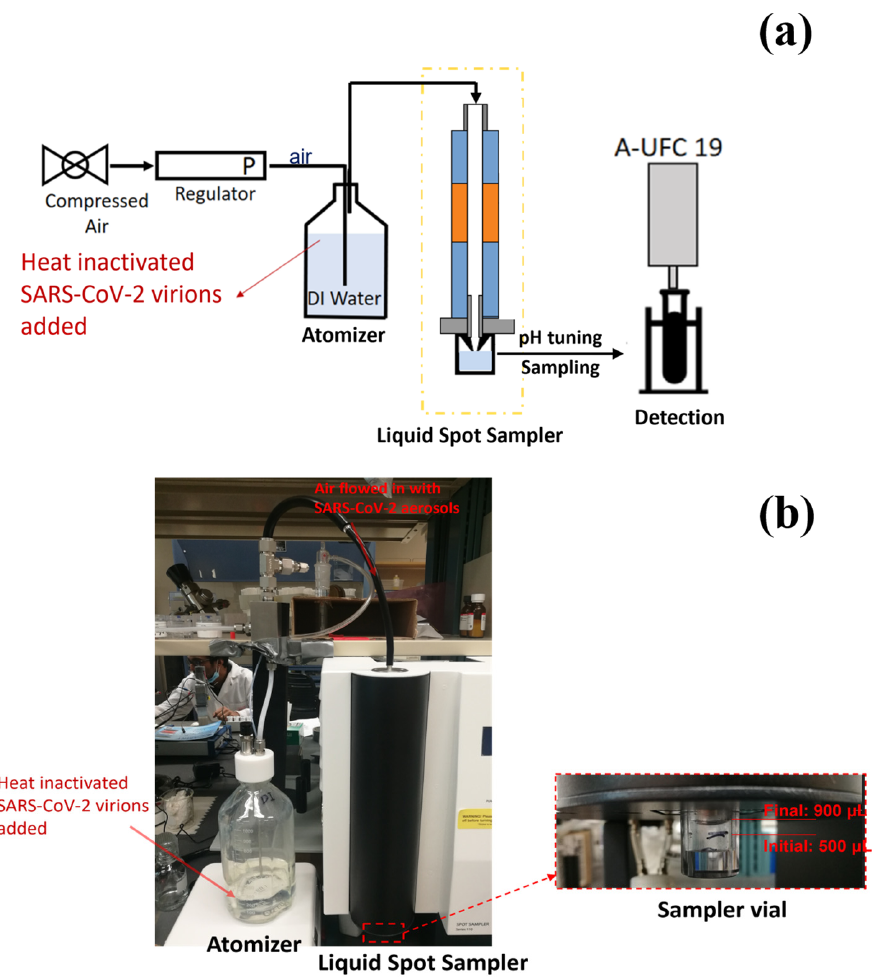
Figure 9. ( a ) Schematic of the test rig using TSI Atomizer and Liquid Spot Sampler. ( b ) Picture of the experimental setup used in the test rig.